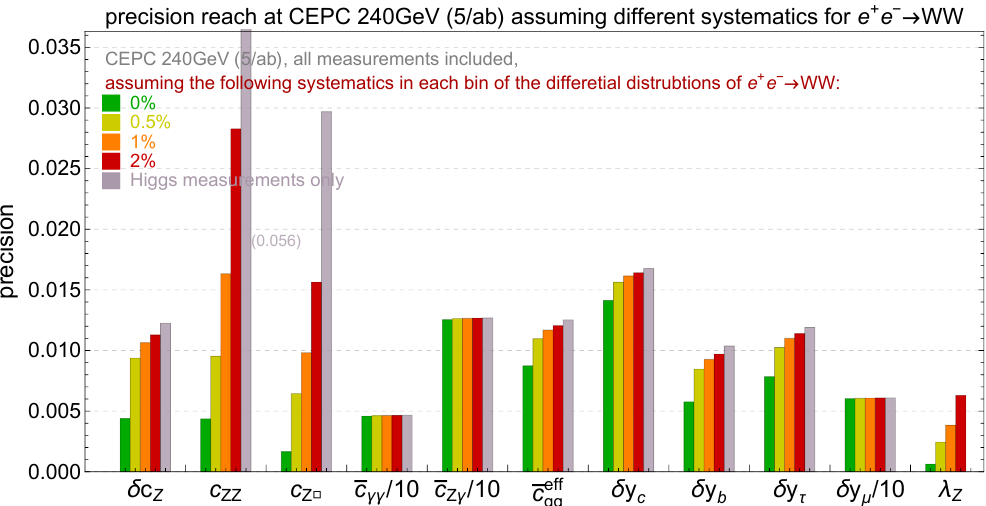
Figure 12 . Top: one-sigma constraints on aTGCs parameters for di(cid:11)erent assumptions about the systematic uncertainties a(cid:11)ecting the e + e measurements at the CEPC. Each of the (cid:12)ve (cid:0) ! WW angular distributions is divided into 20 bins (or 10 bins for the angles characterizing W decays in indistinguishable quark-antiquark pairs). We assume a (cid:12)xed relative uncertainty each bin, and no correlation among them. A benchmark value of 1% is used elsewhere in this paper, for CEPC and FCC-ee measurements. Bottom: one-sigma reach of the 240 GeV CEPC run for di(cid:11)erent systematic uncertainties in the di(cid:11)erential measurements of diboson